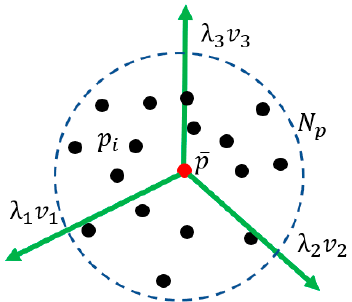
Figure 6. Neighbourhood and covariance analysis, images adapted from